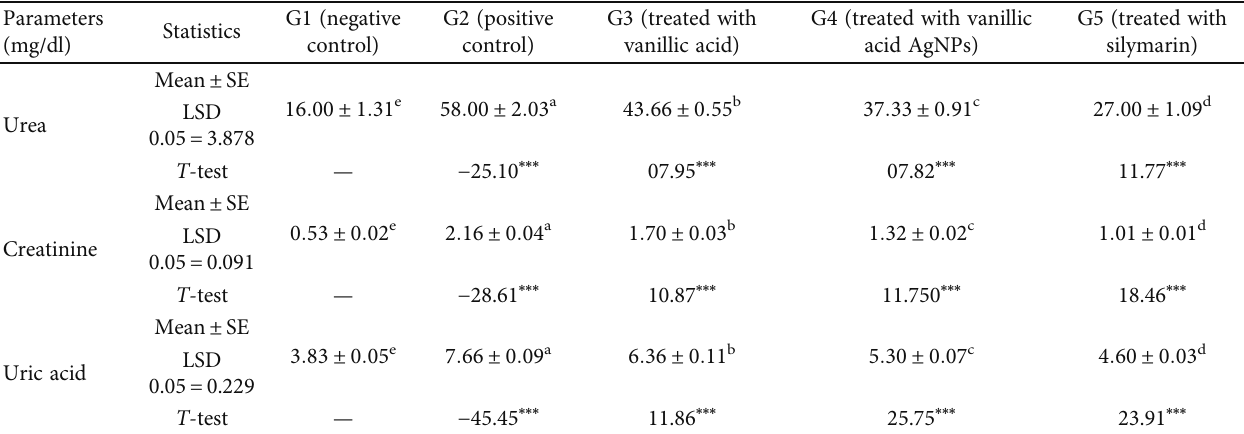
Table 1: E ff ect of treating CCl -induced nephrotoxicity in male rats vanillic acid, vanillic acid AgNPs, and silymarin on kidney function 4 indices.